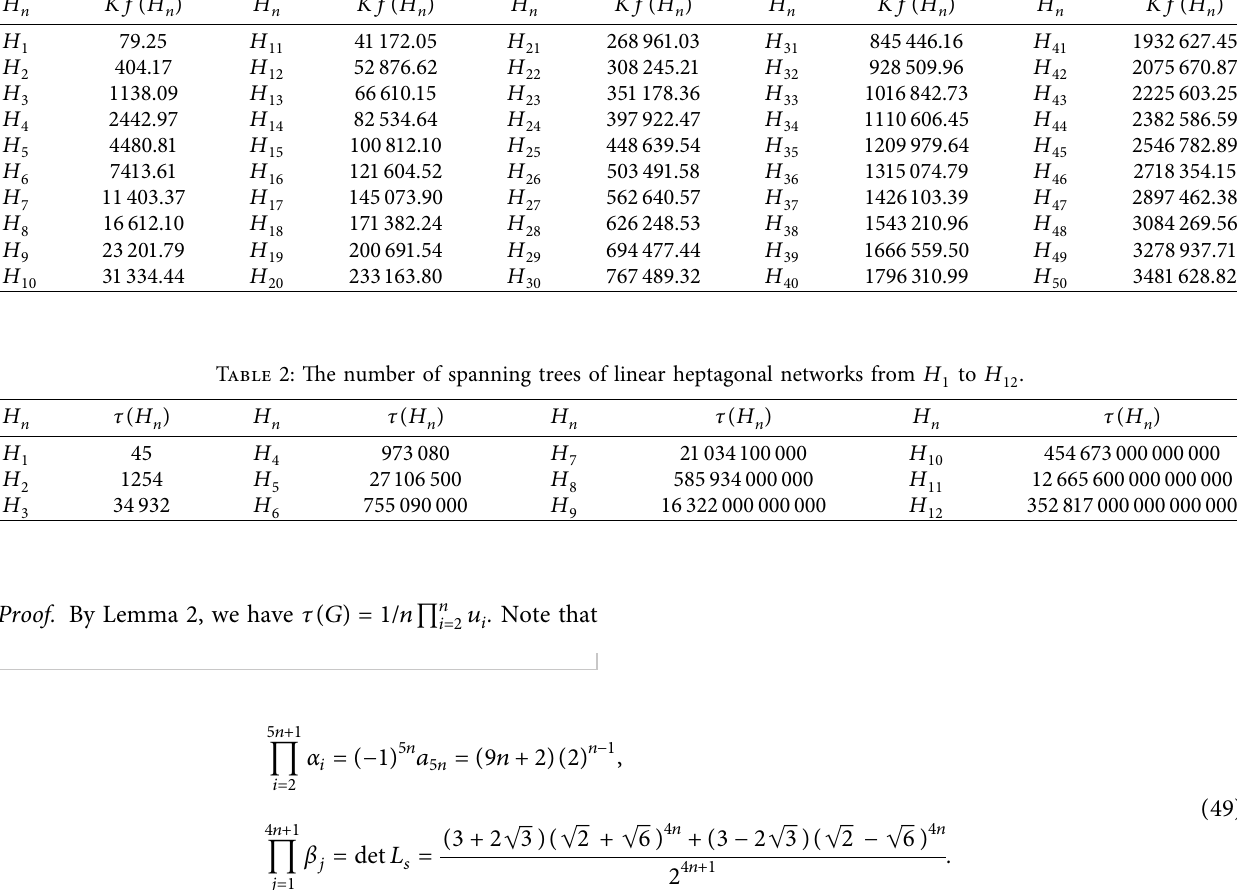
Table 1: Kirchhoff indices of linear heptagonal networks from H